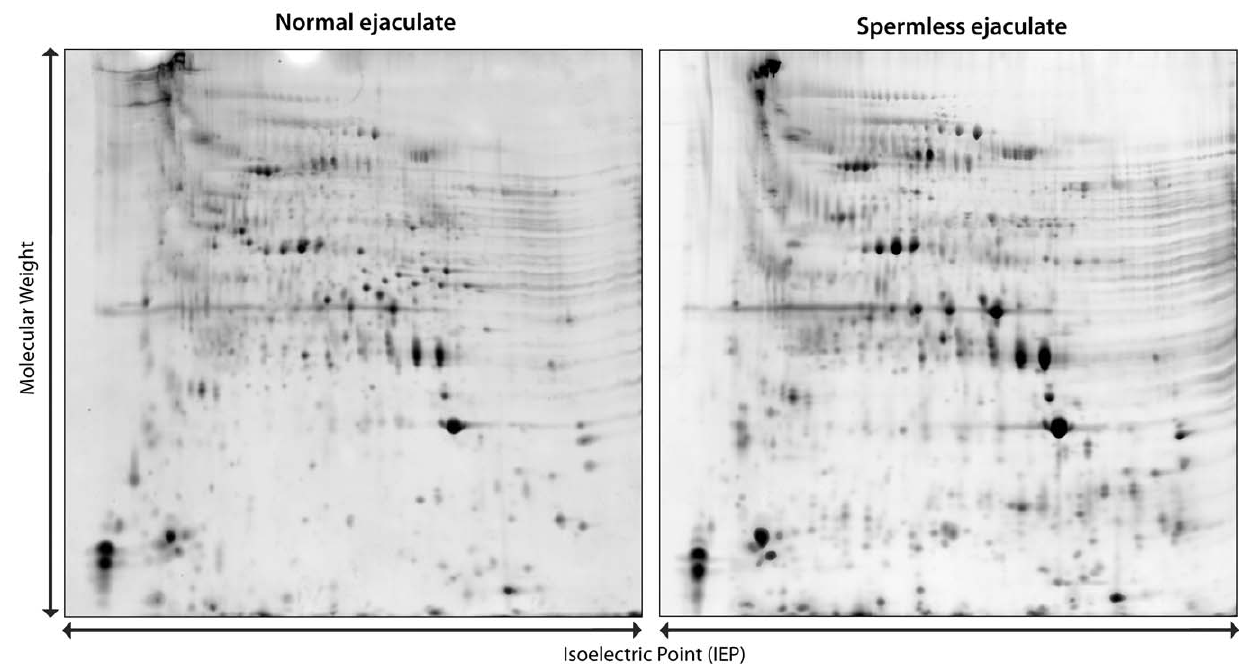
Figure 3. Two-dimensional gel electrophoresis of male ejaculates. Protein gels of a normal male ejaculate (left) and a spermless male ejaculate (right). Spermatophore samples were ground and centrifuged to remove spermatophore debris and sperm. Proteins were separated based on their isoelectric point in the first dimension and molecular weight in the second.